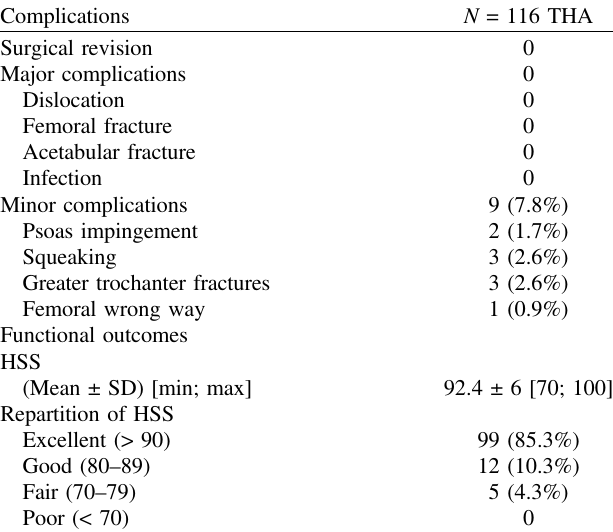
Table 2. Intra and post-operative complications of THA, and post- operative functional outcomes at the last